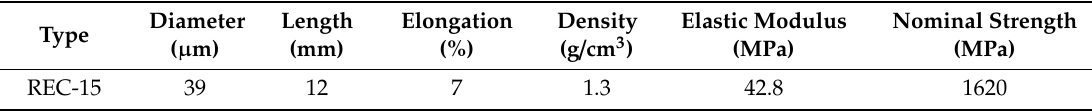
Table 4. Mechanical properties of PVA